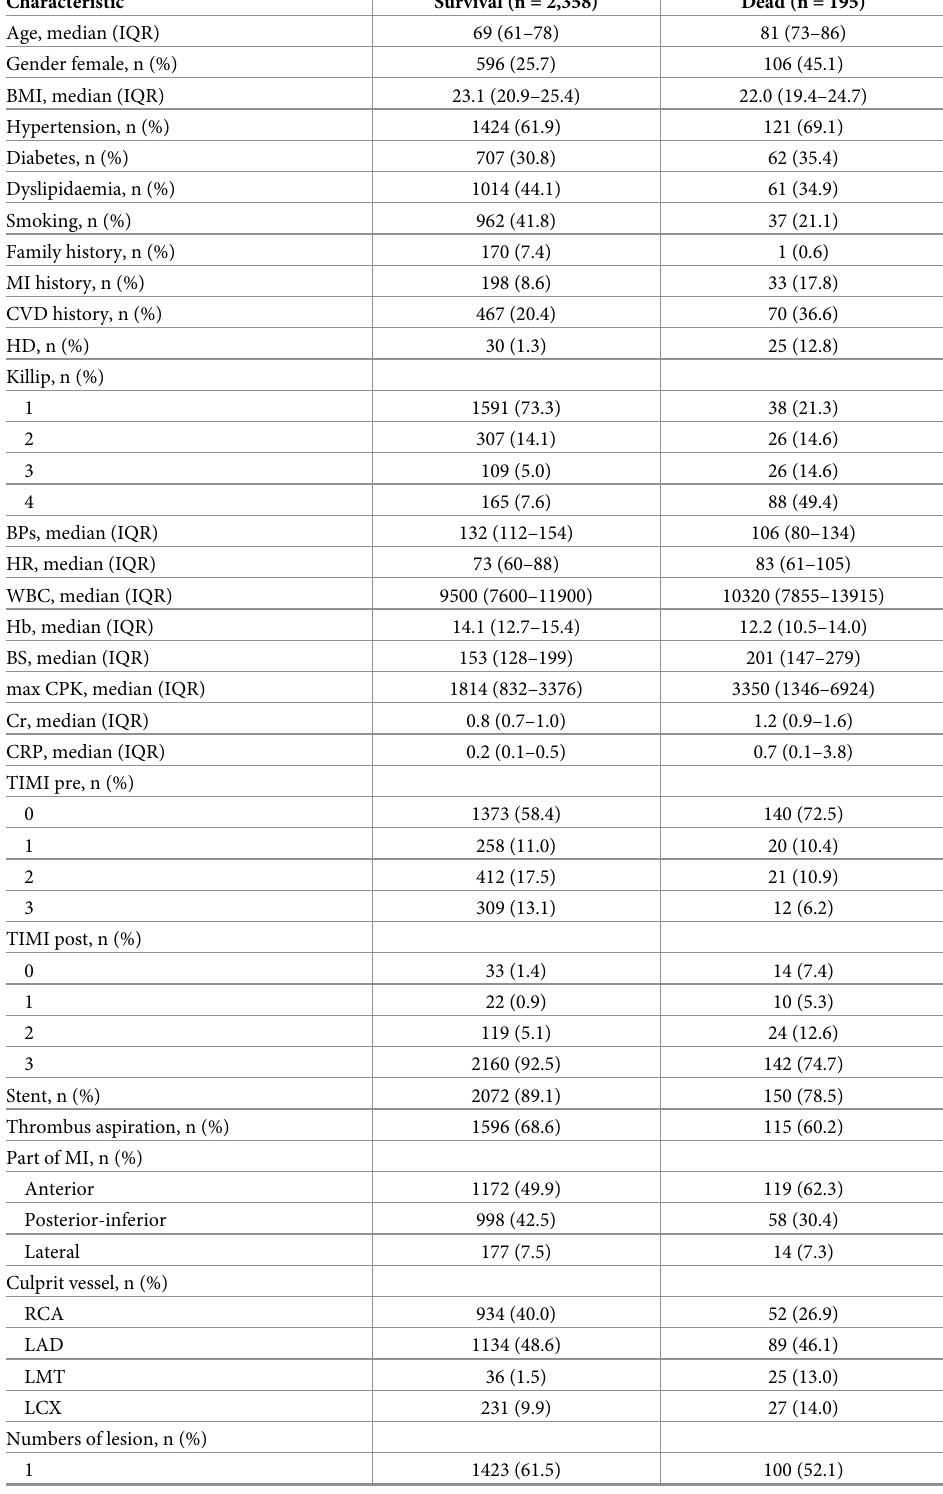
Table 1. Characteristics of